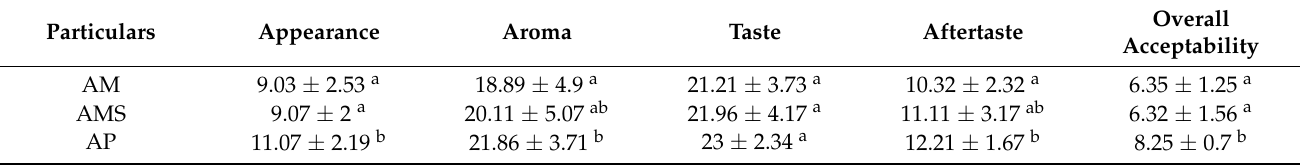
Table 3. Sensory analysis of alcoholic beverages of